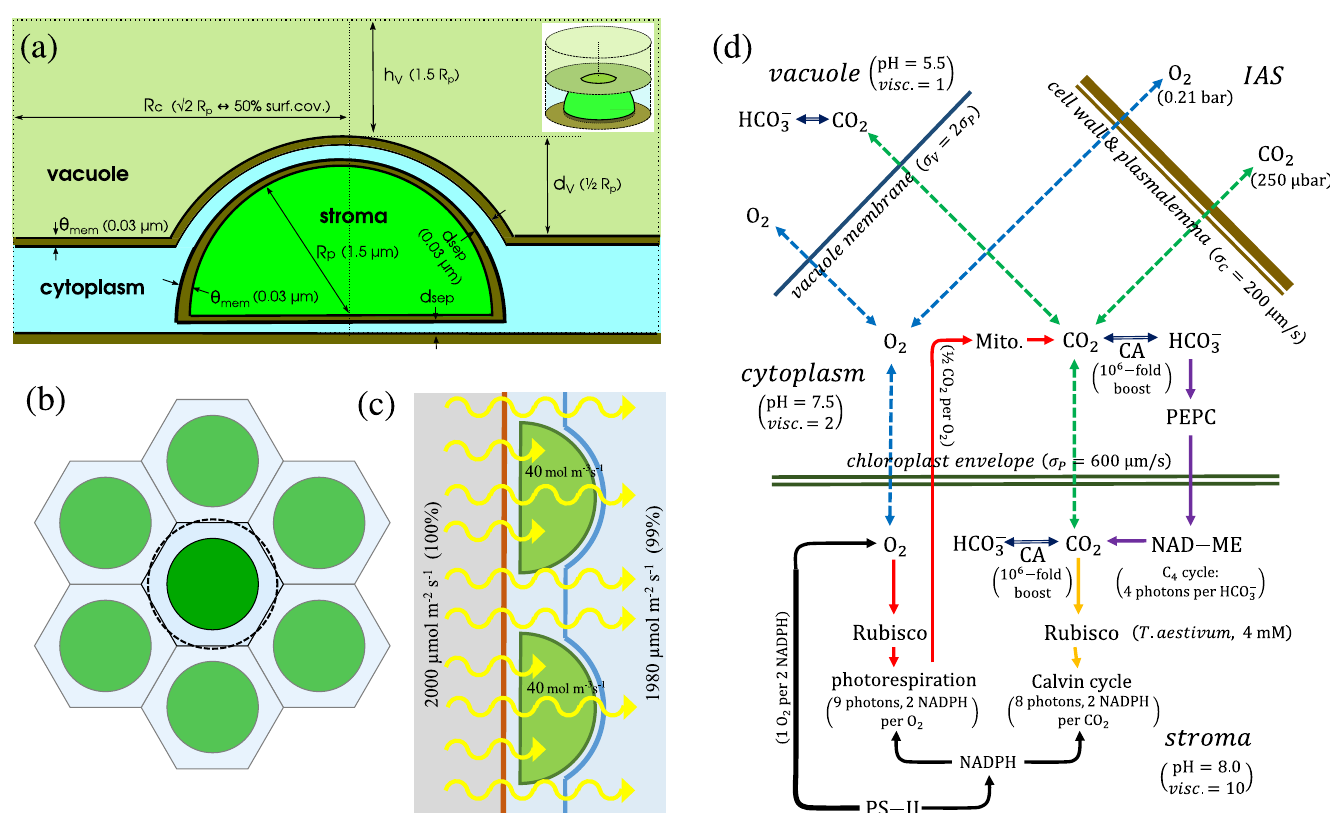
Fig 1. The spatial single-cell C 4 photosynthesis model. (a): the cross-section of the simulated cylindrical volume (insert) containing a semispherically shaped chloroplast, the peripheral cytoplasm, and a part of the vacuole interior (not to scale). The cylinder radius is determined by the chloroplast surface coverage. (b): The cylindrical symmetry approximates the ‘personal’ space of an individual chloroplast in a roughly hexagonal close-packed arrangement of chloroplasts in the areas of mesophyll surface adjacent to internal airspaces. An arrangement is shown at 50% surface coverage ratio. The simulated cylinder is represented by the dashed circle. (c) A comparison of the chloroplast light-harvesting capacity expressed in terms of photon absorption per stromal volume and the fraction of maximal incoming solar flux it would correspond to. An array of a 1.5 μ m radius chloroplasts with 40 mol m -3 s -1 light-harvesting capacity at 50% cell surface coverage could capture 1% of maximal-insolation photon flux incident on the cell surface. (d): A schematic representation of the physical processes and chemical pathways modelled. O 2 , CO 2 , and HCO 3- can freely diffuse within individual regions, but O 2 and CO 2 can also diffuse through interregional boundaries (dashed green and blue arrows). Depending on the region, the interconversion of CO 2 and HCO 3- (dark blue arrows) proceeds with or without CA assistance. CO 2 reacting with RuBP-primed RubisCO drives the Calvin-Benson cycle (orange arrows). O 2 reacting with RuBP-primed RubisCO activates the photorespiratory pathway (red arrows). HCO 3- reacting with PEP-primed PEPC is the starting point for the carbon transport through the C 4 pathway (purple arrows). Oxygen production at PS-II is coupled to the NADPH consumption in the Calvin-Benson and photorespiratory cycles (black arrows). Parentheses in (a) and (d) show the default parameter values.